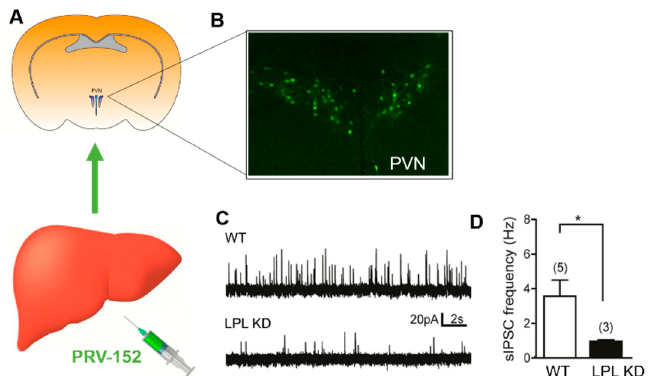
Figure 3. Decreased inhibitory synaptic regulation of liver related paraventricular nucleus (PVN) neurons in LPL KD mice. ( A , B ) Liver-related neurons in the PVN were identified with a retrograde transsynaptic viral tracer (PRV-152) and used for patch-clamp recordings. ( C ) Recordings of spontaneous inhibitory post-synaptic currents (sIPSCs) in WT (LPL flox ) and LPL KD (NEXCreLPL flox ) mice. ( D ) The frequency of sIPSCs was reduced in LPL KD mice compared to WT mice. ( * = p < 0.05 vs. WT).